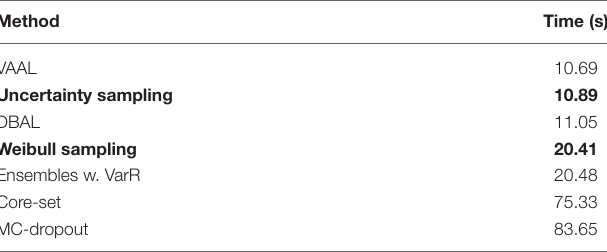
TABLE 1 | Sampling time analysis: mean time to select a sample from the unlabeled pool of